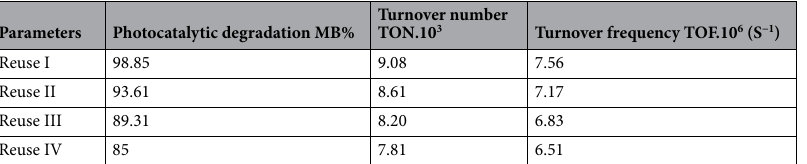
Table 4. TON, TOF for each reuse using MWCNTs/ZnO/Chitosan. TON turnover number: mole of degraded MB per mole of active photocatalyst, TOF turnover frequency: mole of degraded MB per mole of active photocatalyst after 20